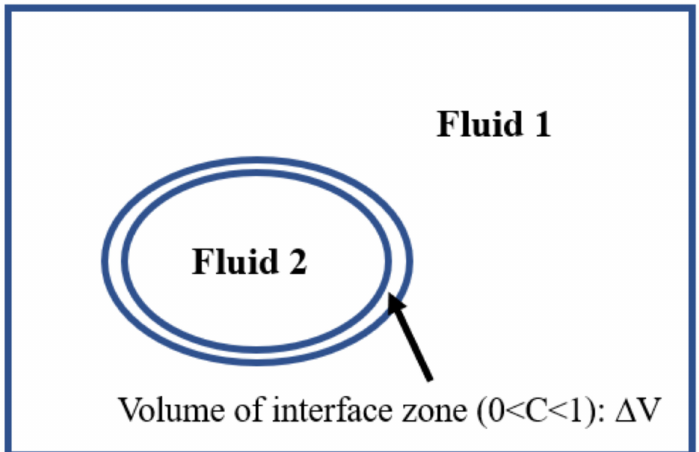
Figure 1. Illustration of the structure for two-phase